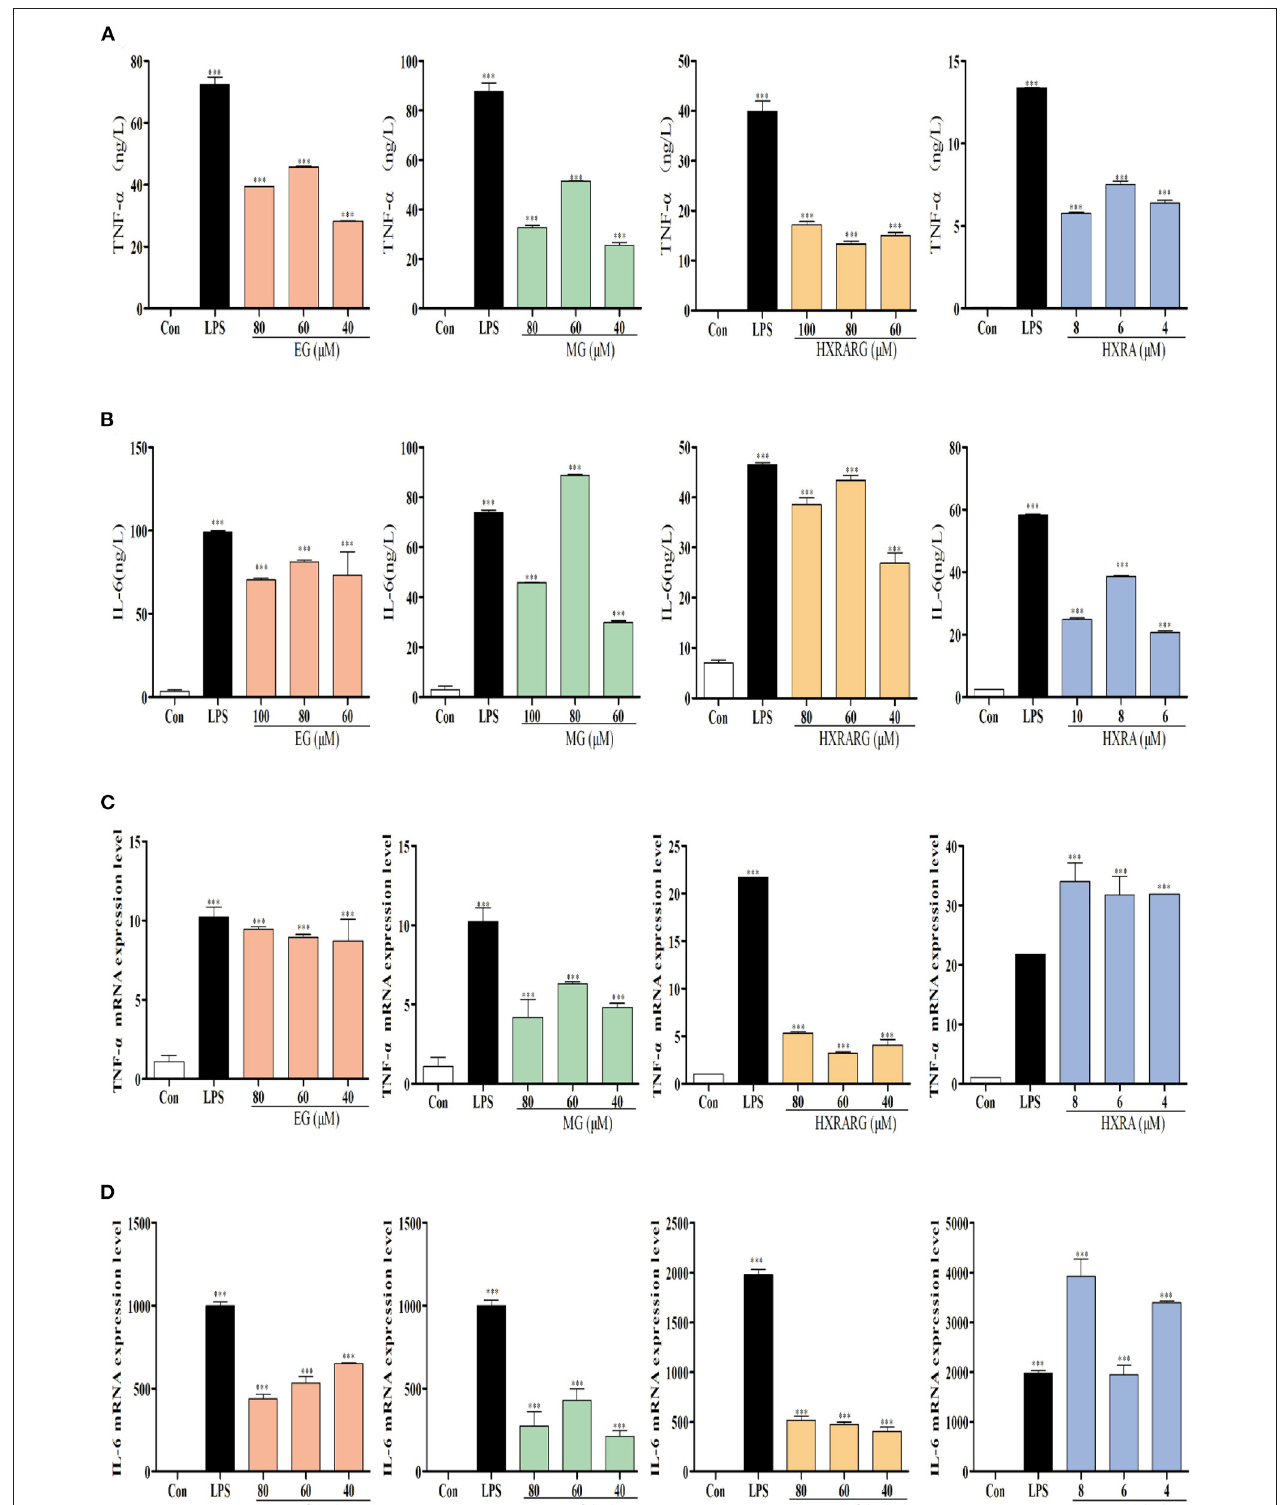
FIGURE 6 | Effects of EG, MG, HXRARG and HXRA on the expression of tumor necrosis factor- α (TNF- α ), interleukin-6 (IL-6) and mRNA in RAW264.7 cells. (A) secretion of IL-6 (B) secretion of TNF- α (C) TNF- α mRNA transcription (D) IL-6 mRNA transcription. Data are expressed as the means ± SD. Data are expressed as the means ± SD. Compared with the control, *** P <